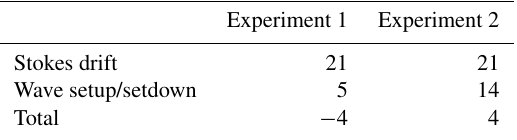
Table 3. Difference of the total and wave contributions to the surface velocities (%) between the WAVECOUPLE and WAVE- FORCE simulations. The results show that while the contribution of the Stokes drift to the total velocities is higher by the same rate for both approaches, the same is not true for the wave setup con- tribution. A more complex interaction between waves and currents derived from the coupling gives rise to stronger nearshore currents in the WAVECOUPLE simulations (positive